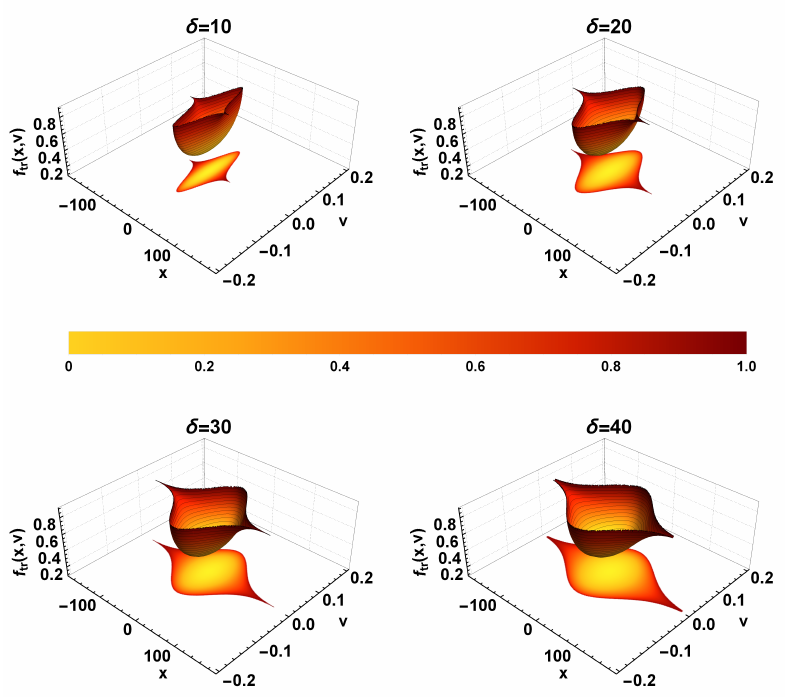
Figure 9. The trapped ion distribution function for different δ keeping T r = 3 and ψ = 0.01 as constants. The values for width and amplitude are from Region 1.